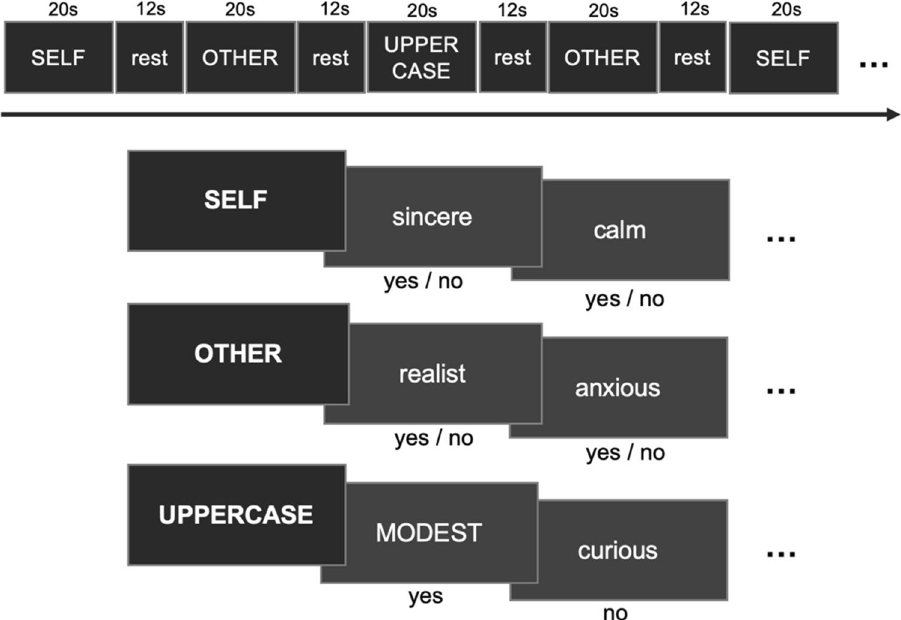
Figure 1. Self-other processing task block-design. The self-other processing task consisted of 15 blocks of 20 s each, interspersed by 12-s blocks of rests. During “Self” blocks, participants were instructed to think about themselves and answer “yes” or “no” to indicate whether the adjective displayed on the screen applies to them or not. During “Other” blocks, participants were instructed to think about one person they know and then answer “yes” or “no” to indicate whether the adjective displayed on the screen applies to that person. During “Uppercase” blocks, which served as a control condition, subjects were instructed to press “yes” if the displayed word was in uppercase, and “no” if it was in